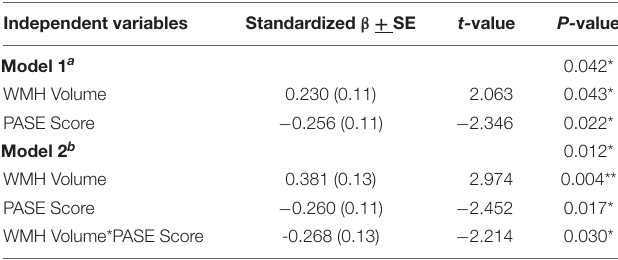
TABLE 2 | Results of the linear regression analyses. Independent variables